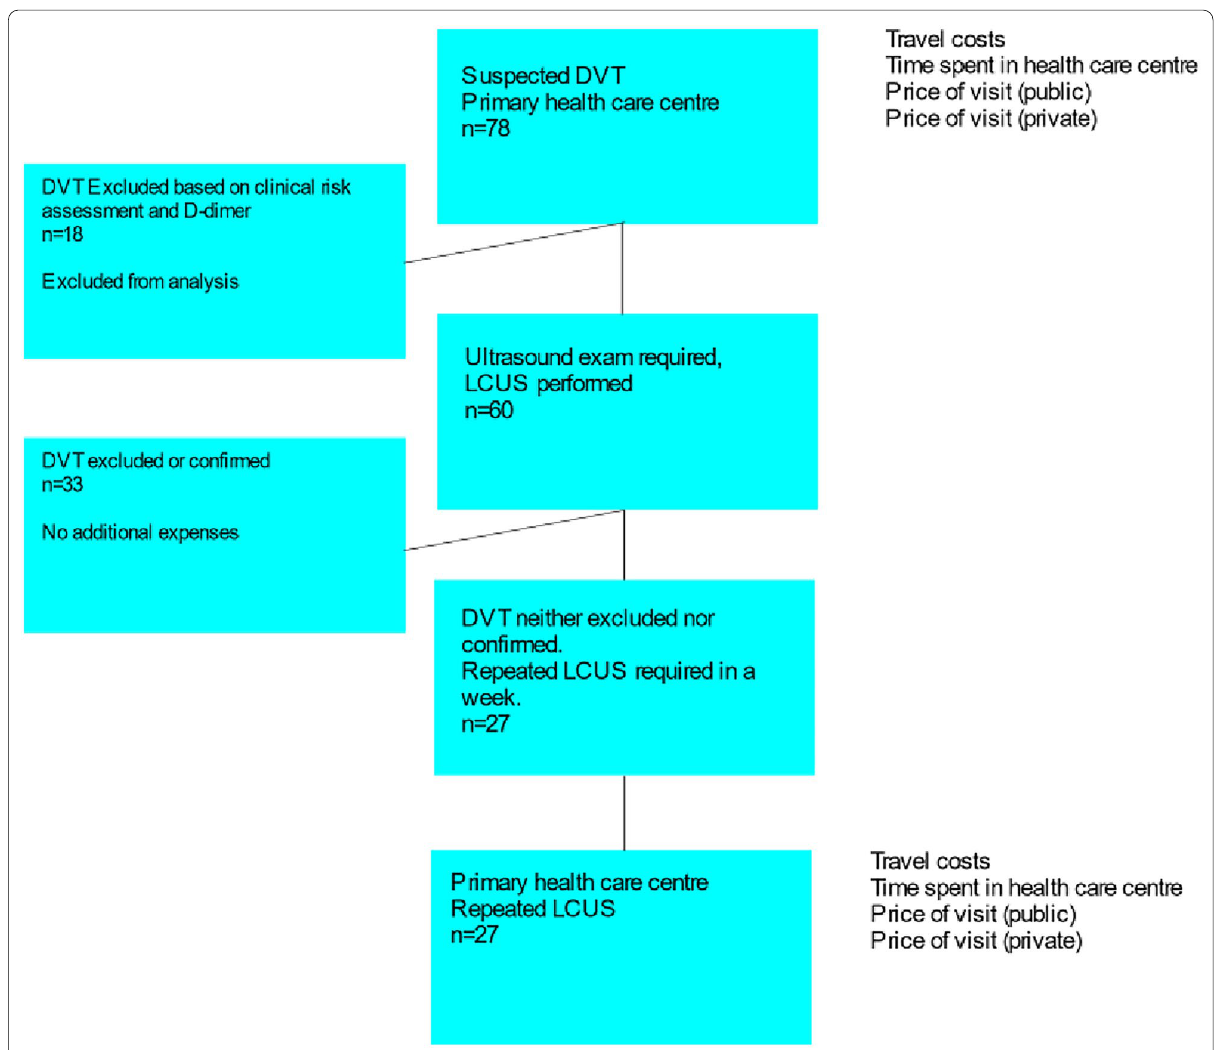
Fig. 2 LCUS pathway of DVT diagnostics. The costs associated with different parts of the pathway are